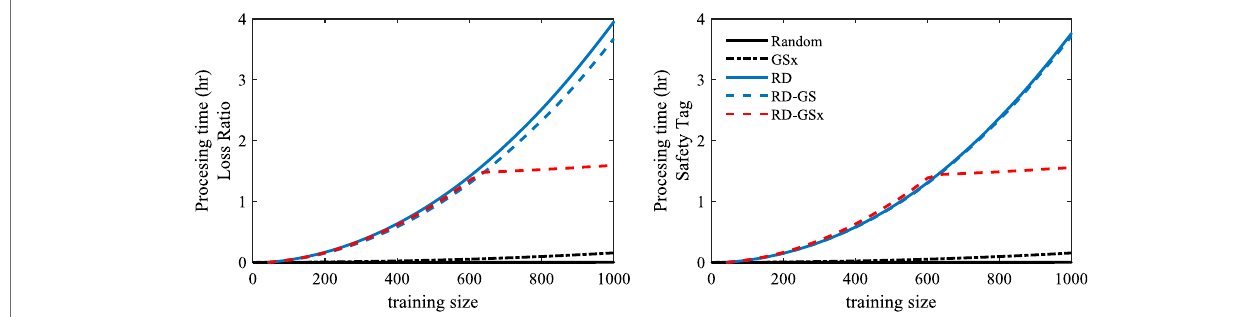
FIGURE 9 | Comparison of computational demand between sampling methods.